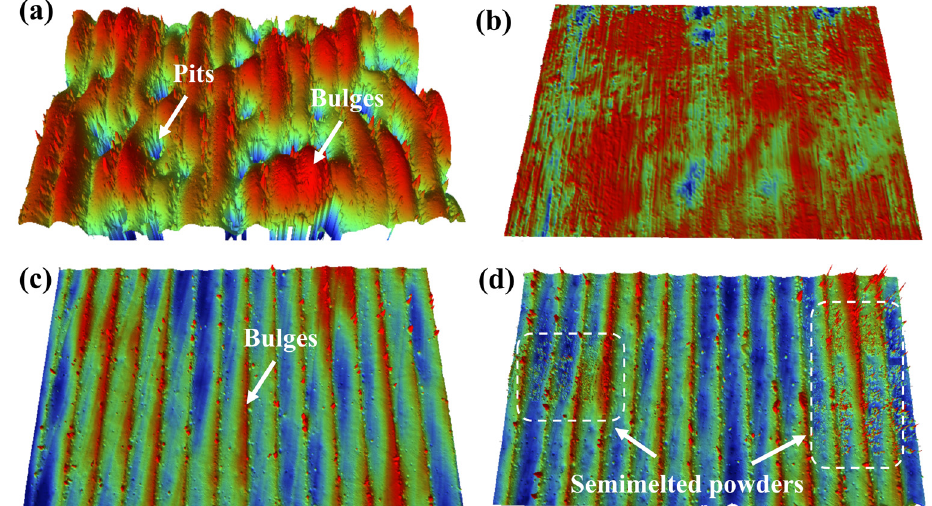
Figure 8. Surface morphology represented by di ff erent values of S sk . ( a ) S sk < 0; ( b ) S sk = 0; ( c ) S sk : 0.2–0.5; ( d ) S sk ≥